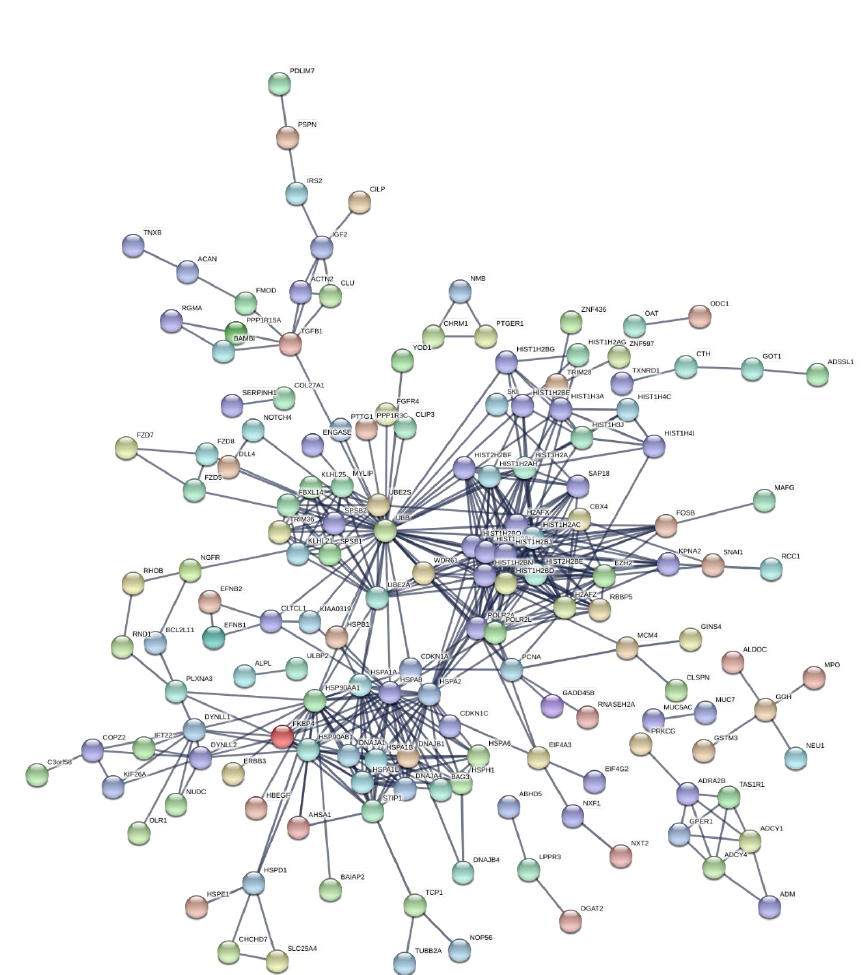
Figure 3. ( A ) CF-related over-represented terms. DEGs obtained from Myr-treated and untreated A. fumigatus -infected CF monocytes; the comparisons were used for performing over-representation analysis (ORA) using GO, KEGG, and MSigDB terms. Here are shown the enriched terms (adjusted p -value < 0.05) matching the top functional categories related to CF including autophagy, infection, inflammation, and lipid metabolism. On the x -axis, the number of DEGs belonging to the enriched term. ( B ) Volcano plot showing DEGs distribution between up- and downregulated genes with labels for the top 20 significant DEGs. On the x -axis, the log2Fold change, and on the y -axis the adjusted p - value (−log10). ( C ) STRING analysis of up regulated DEGs in treated versus untreated comparison.